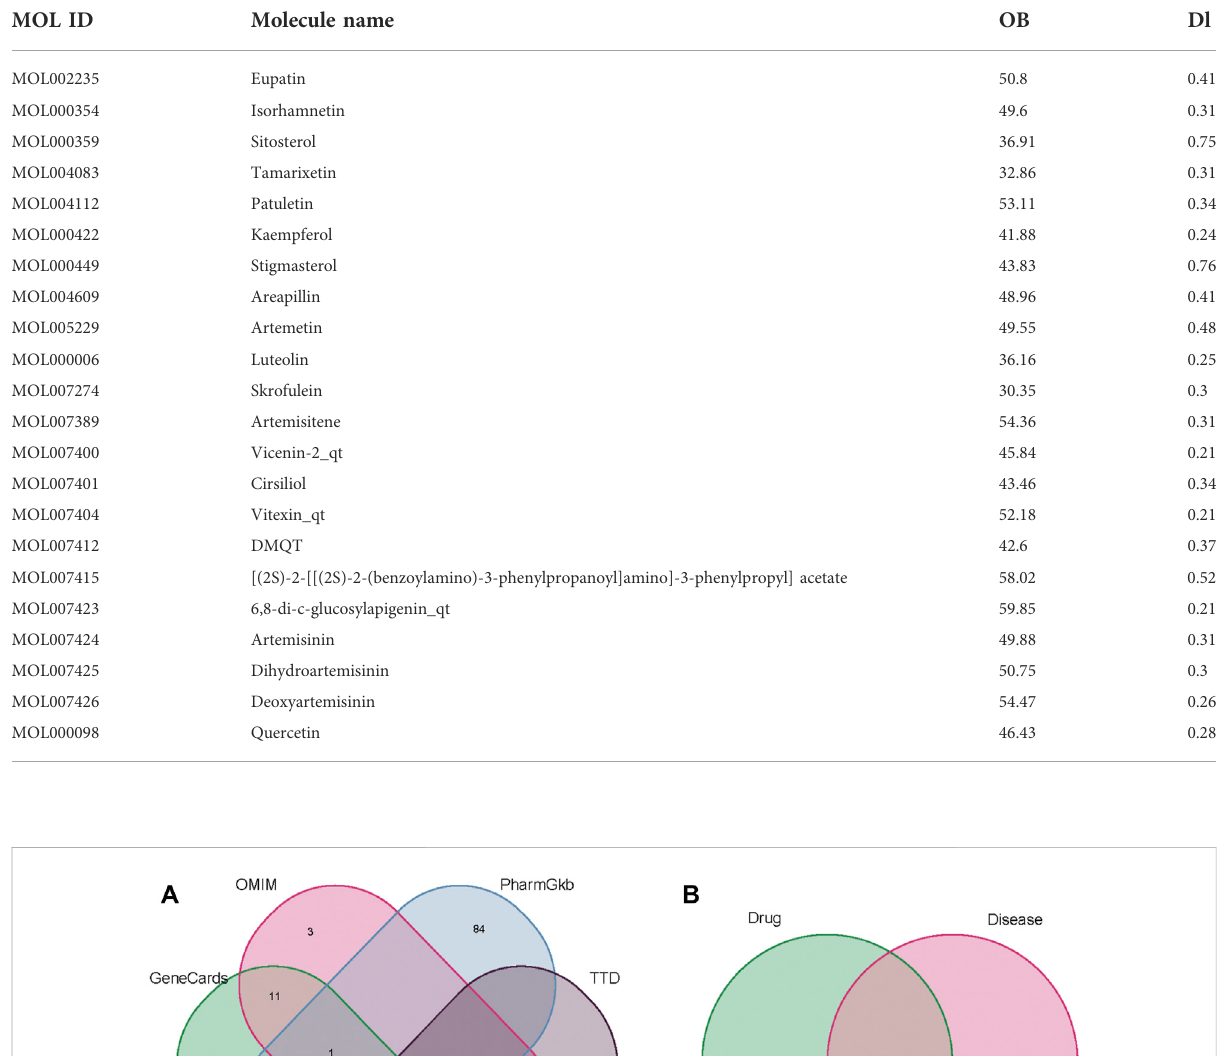
TABLE 1 The main active ingredients of A. annua .